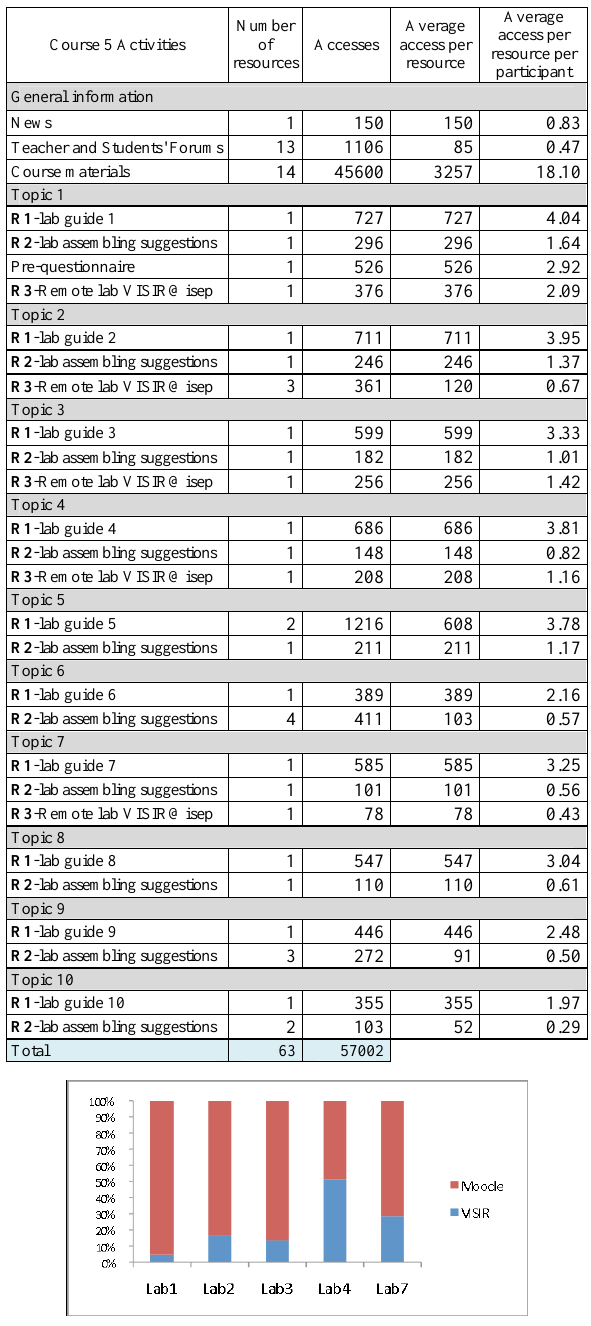
Figure 2. Course 5: direct access to VISIR and accesses via Moodle. TABLE II. O VERVIEW OF M OODLE RESOURCES AND ACCESSES PER COURSE